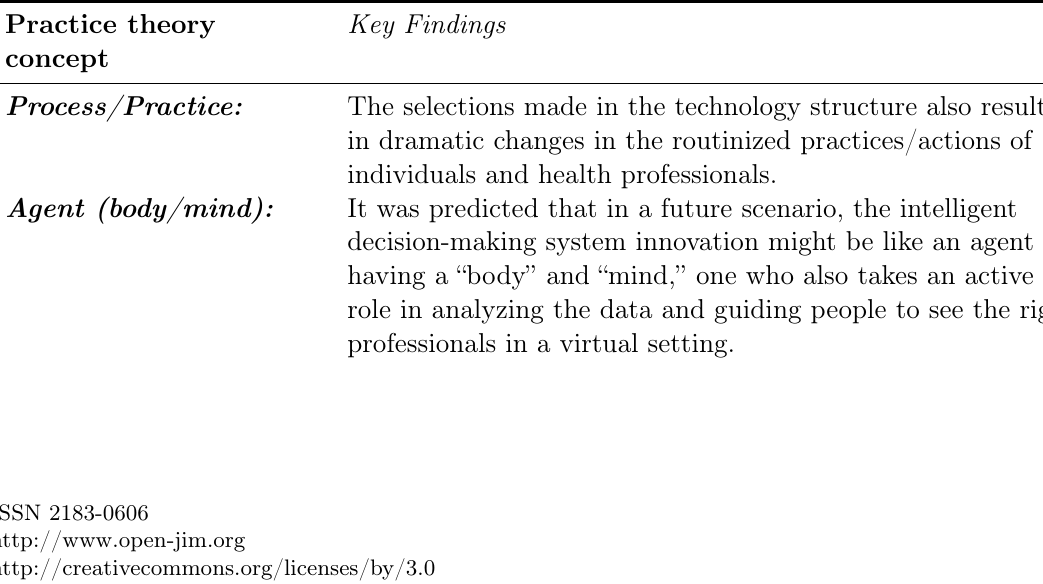
Table 3. Key Findings of the